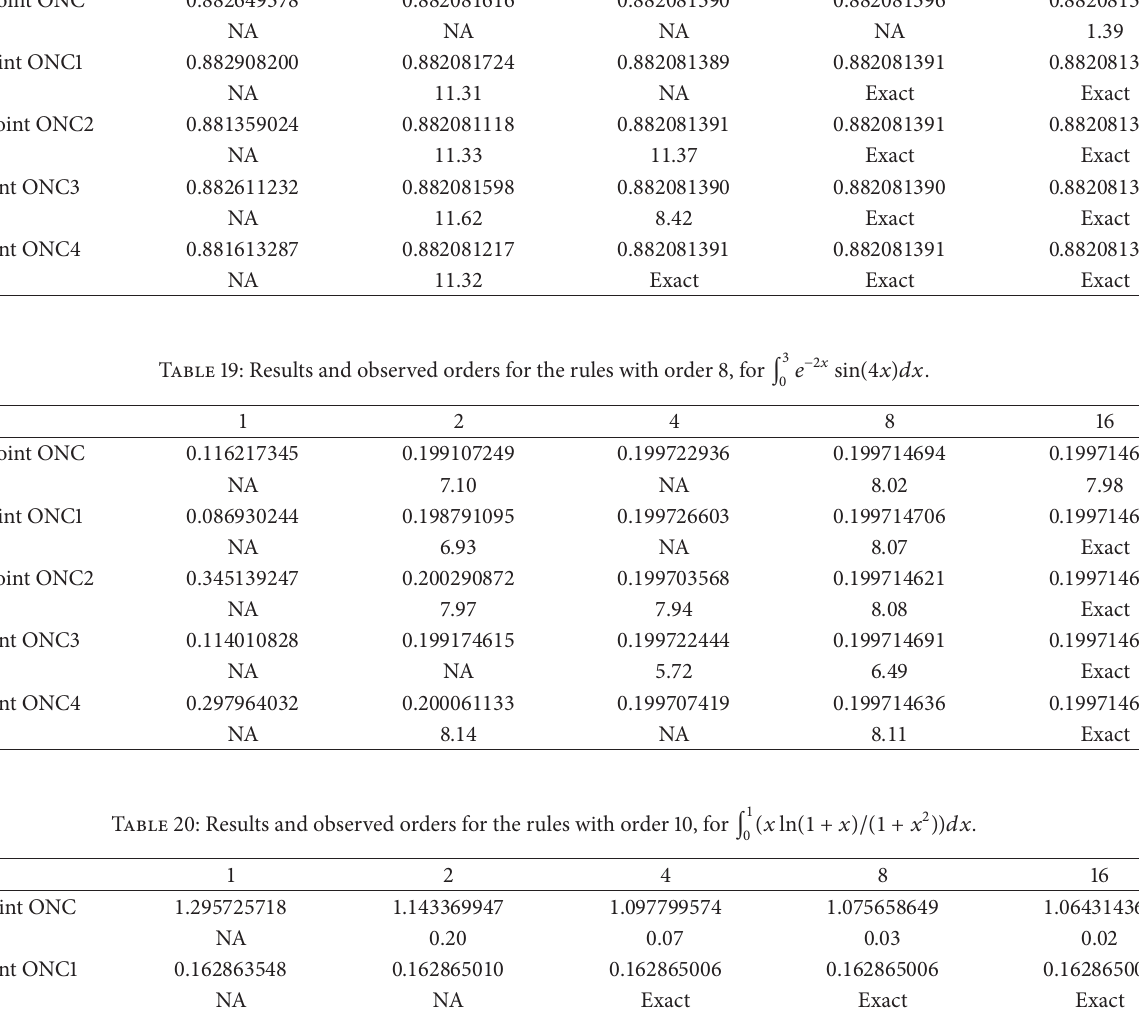
Table 18: Results and observed orders for the rules with order 8, for ∫